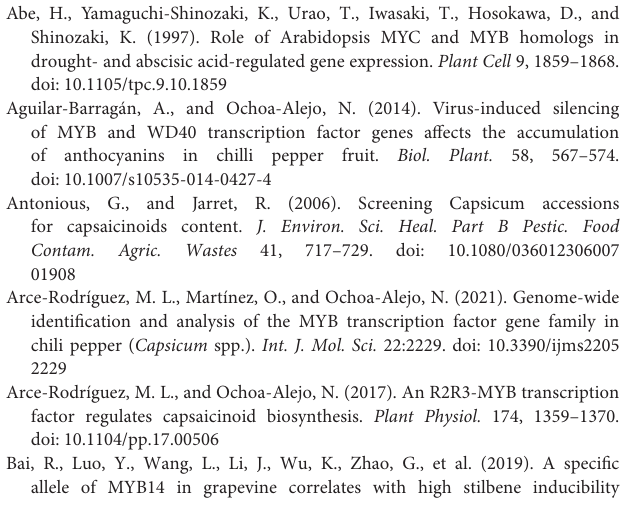
Supplementary Figure 6 | Relative expression of eight CcMYB genes in six genotypes, three C. annuum (Kosom Moso, JH15 and JH7) and three C. chinense (Lota, CCGHY6, and BJS) by qRT-PCR in the three fruit developmental stages. A Student t -test was performed to calculate the significant difference of expression. The significance level was represented as ∗∗∗ p < 0.001; ∗∗ p < 0.01, and ∗ p < 0.05. Supplementary Table 1 | Primer sequences used for the qRT-PCR expression analysis of CcMYBs and capsaicinoids biosynthesis pathway genes. Supplementary Table 2 | The characteristic features of Capsicum MYBs. (A) C. chinense (CcMYBs) and (B) C. annuum ( CaMYBs ) genes with RNAseq expression data in the three fruit developmental stages. (C) C. baccatum ( CbMYBs ) along with their genomic coordinates. Supplementary Table 3 | Conserved amino acid motifs identified in CcMYB protein sequences using the MEME suite. Supplementary Table 4 | Cis-regulatory elements identified in the 1.5-kb upstream promoter region of CcMYBs using the PLANTCare database. (A) Cis-acting elements along with their sequences, function, and presence in the MYB genes and (B) their frequency in the upstream region of each MYB gene. Supplementary Table 5 | RNA sequencing alignment summary. Raw reads and aligned read summary with Hisat2 in the (A) C. chinense and (B) C. annuum fruit samples. Supplementary Table 6 | The 126 R2R3 CcMYBs and the probability and identity of their corresponding homologous protein model/template. Supplementary Table 7 | MYB containing conserved syntenic segments (CSSs) from the Capsicum chinense genome compared with the C. annuum, C. baccatum, tomato, potato, and Arabidopsis genomes [Note: Cc, Ca, Cb, St, Sl, and At represent the chromosomes from the C. chinense, C. annuum, C. baccatum, potato, tomato, and Arabidopsis genomes]. Supplementary Table 8 | The C. chinense ( CcMYBs ) and their homologous gene pairs from C. annuum , C. baccatum , tomato, potato, and Arabidopsis along with the Ka/Ks ratios and duplication time (in MYA) for each homologous pair. Supplementary Table 9 | SSRs identified in the MYB genes and 1.5-kb promoter regions in C. chinense with the primer sequences and the amplicon size of the SSR motifs. Supplementary File 1 | CDS and protein sequences of C. chinense MYB family